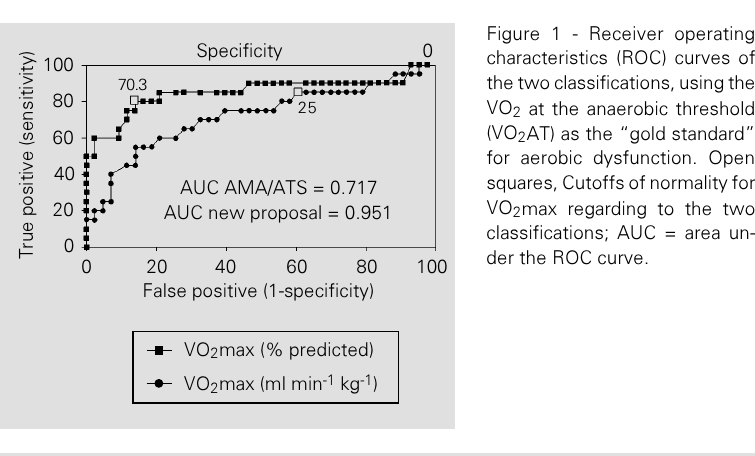
Table 3 - Concordance between classifications of aerobic function: remaining ability